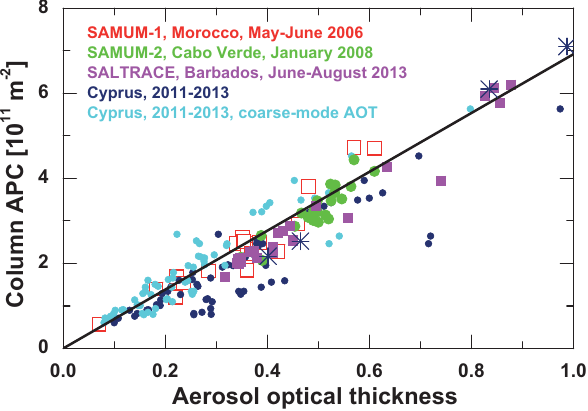
Figure 2. Correlation between aerosol optical thickness (500nm AOT) and column-integrated aerosol particle number concentra- tion (column APC 280 ) considering particles with r > 280nm. Desert-dust-dominated observations from several field campaigns (SAMUM-1, large red open squares, SAMUM-2, green circles, SALTRACE, small pink squares) and from long-term observations at Limassol from 2011 to 2013 are considered. For Cyprus, coarse- mode (light blue circles) and total (fine + coarse-mode, deep blue circles) AOTs are correlated with column APC 280 . In the case of the stars (four Cyprus observations with total AOT from 1.6–4), AOT and column APC values are divided by 4. Least squares fitting to all shown data (except the dark blue Cyprus values) yield the black solid line with the slope of 6.85 × 10 11 m − 2 .